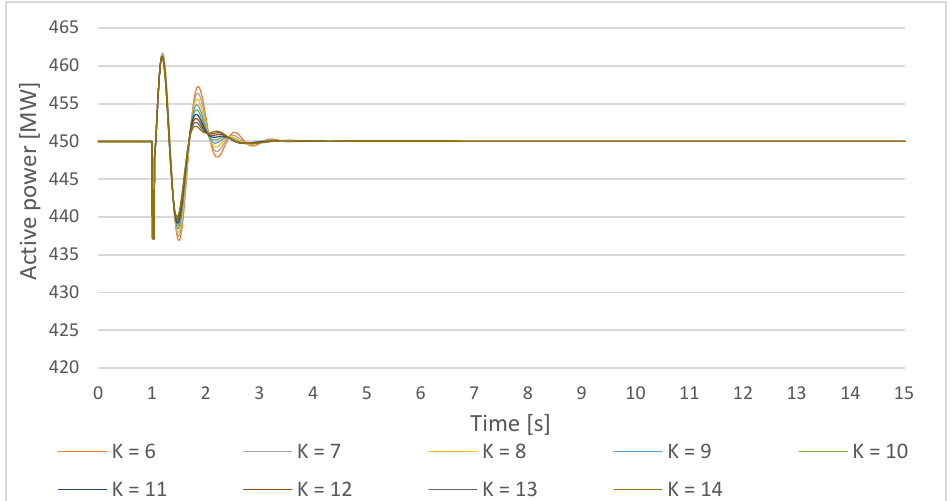
Figure 18. Gen1 active power response on a small disturbance with PSS parameters T = 0,5 s, the PSS gain increase in the lower cluster 1- K i,ln = 6 – 10 and the upper cluster 1 K i,um = 10 – 14. Tables 7 and 8 give an overview of the proposed weight functions. The damping ratio